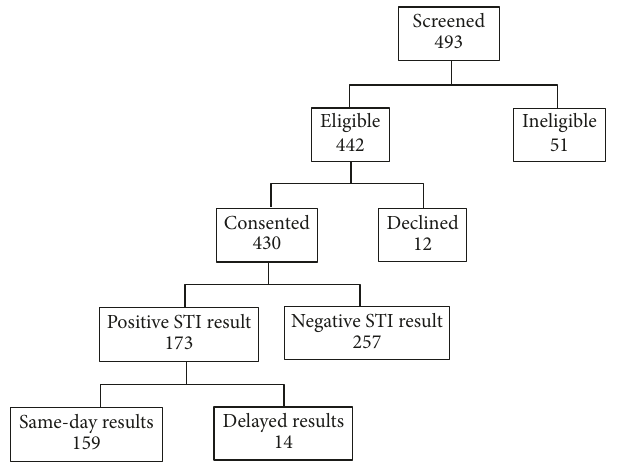
Figure 1: Schematic diagram of the number of women approached, enrolled, and tested in the antenatal screening study in Tshwane District, South Africa (June 2016–October